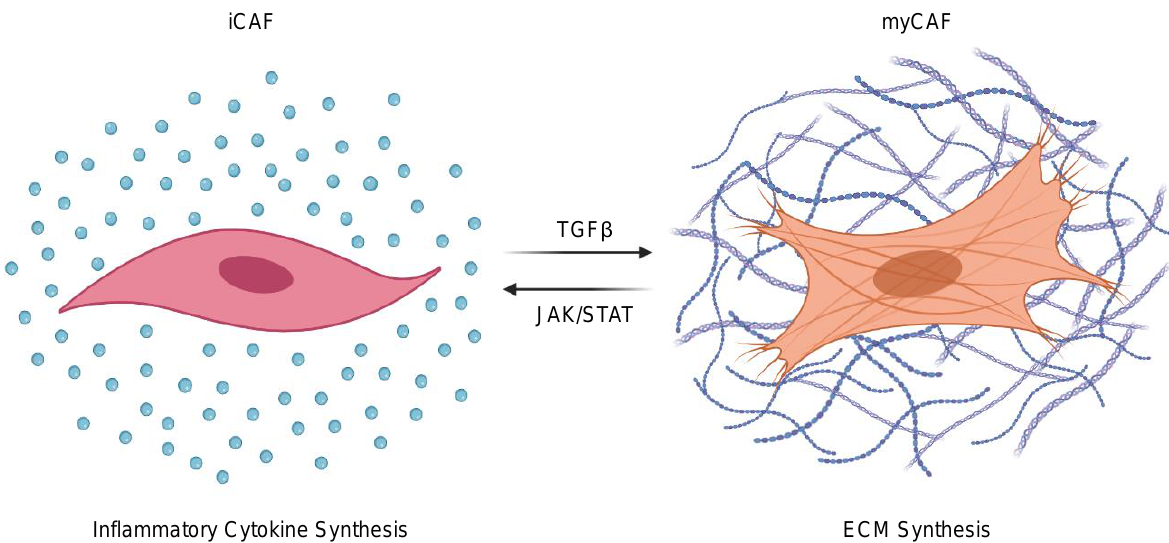
Figure 2. The effects of TGF β signals on cancer-associated fibroblast polarization. Cancer-associated-fibroblasts (CAFs) can be sub-categorized into inflammatory CAFs (iCAFs) that enhance local inflammatory cues through the secretion of cytokines such as interleukin 6 (IL-6) and leukemia inhibitory factor (LIF); and myofibroblastic CAFs (myCAFs) that hyper-secrete extracellular matrix (ECM) proteins. The balance between iCAFs and myCAFs is determined by competition between TGF β and JAK/STAT signaling pathways, where TGF β signaling polarizes CAFs toward a pro-fibrotic myCAF phenotype.